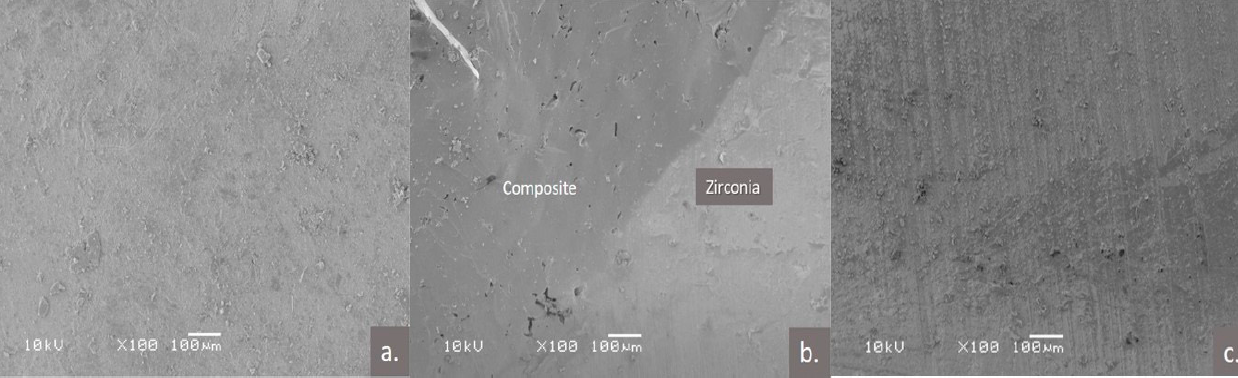
Figure 4. Representative scanning electron microscopic images of; ( a ) composite surface; ( b ) composite zirconia interface; ( c ) zirconia surface after the repaired composite chip off, small remnants of the composite can be noted.